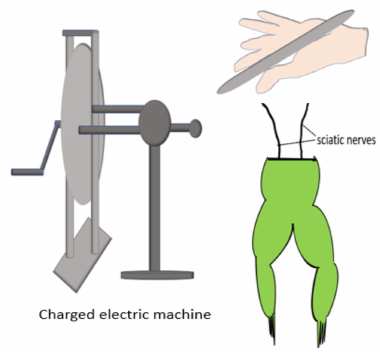
Figure 1. Luigi Galvani and the prepared frog next to the spark experiment. A prepared frog consisted of both the lower limbs with the internal crural nerves exposed from the spinal cord level, and a metal wire was inserted across the vertebral canal and positioned a distance away from a charged electrical machine. The frog’s legs contracted powerfully when an assistant of Galvani, most likely his wife Lucia Galeazzi Galvani, accidentally touched the internal crucal nerves with a lancet. In the meantime, a spark was observed from the nearby electrical machine. This observation led Galvani to study animal